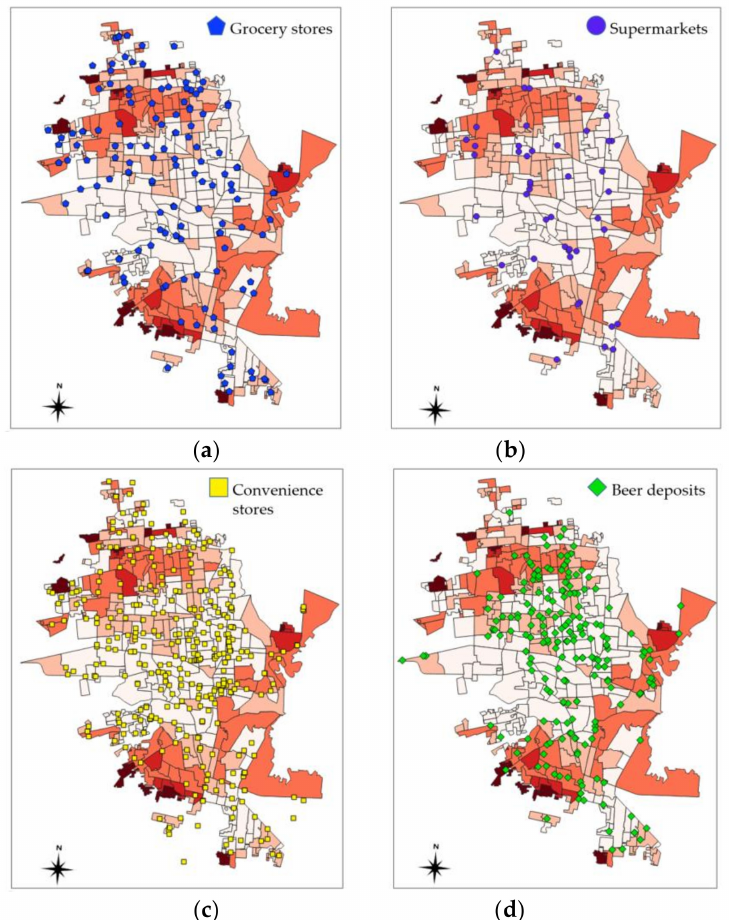
Figure 5. Spatial distribution of food establishments in Hermosillo ( n = 760): ( a ) grocery stores, ( b ) supermarkets, ( c ) convenience stores, and ( d ) beer